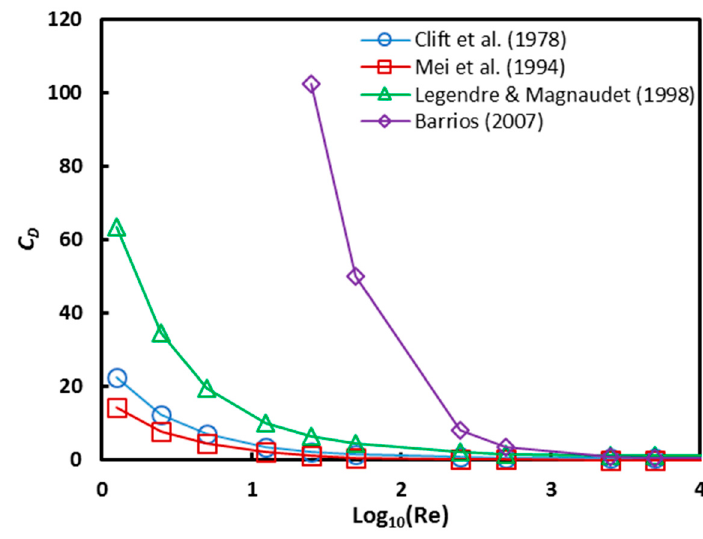
Figure 21. Comparison of drag coefficient models.